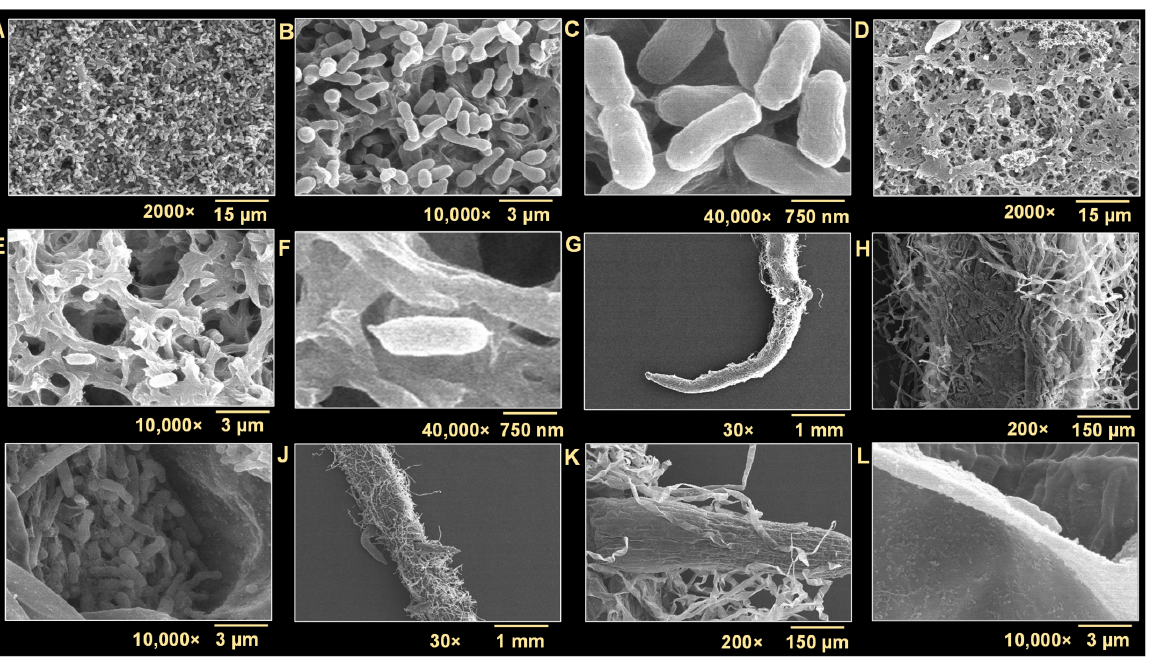
Figure 6. A. tumefaciens biofilm formation (48 h at 30 °C in LB) by nontreated cells ( A – C ) and tannic acid (200 μ g/mL) treated cells ( D – F ) on nitrocellulose membranes. Biofilm formation by A. tumefa ‐